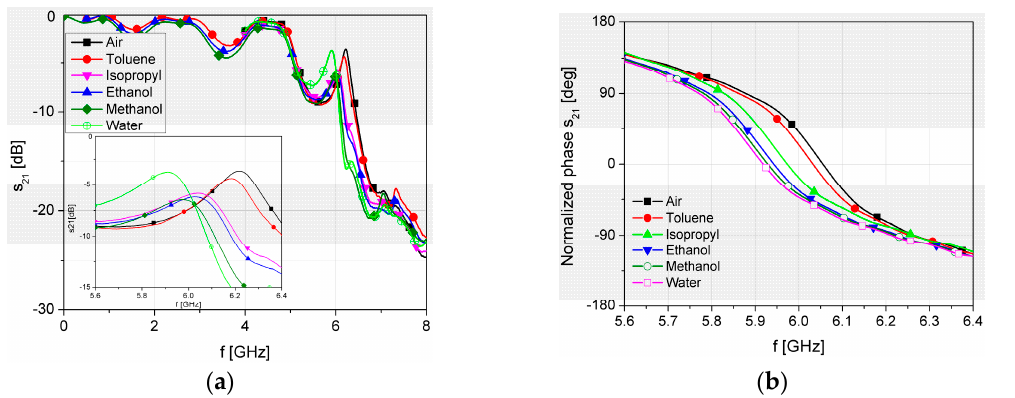
Figure 10. Measured results of the proposed sensor with different fluids inside the microfluidic channel: ( a ) Transmission characteristic; and ( b ) Normalized phase. ( a ) Transmission characteristic; and ( b ) Normalized phase.